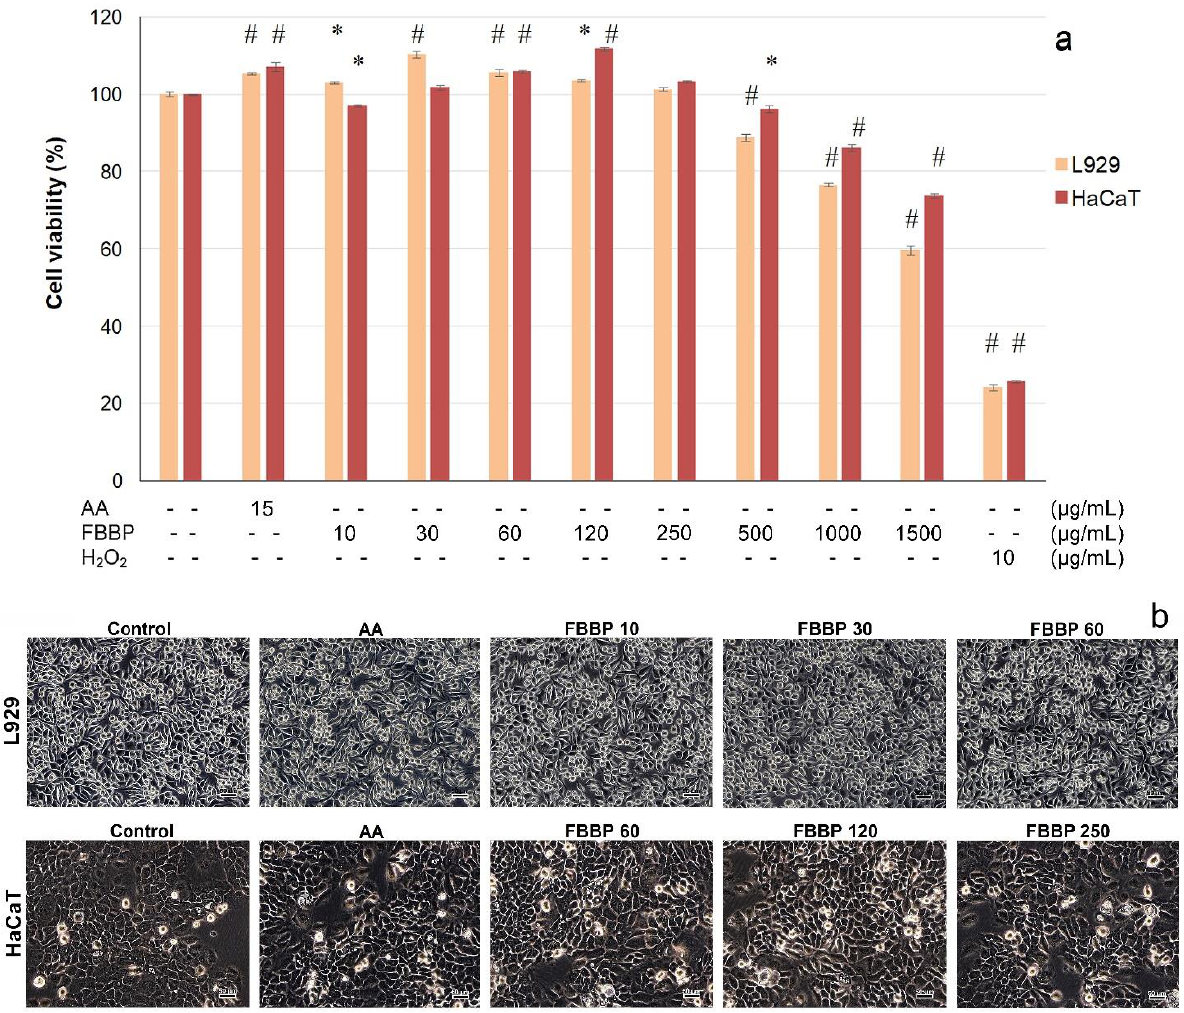
Figure 3. Cell viability of L929 and HaCaT cells cultivated in the presence of different concentrations of FBBP and AA at 48 h of cultivation, evaluated by MTT assay ( a ). The values are expressed as mean ± SD ( n = 3). * p < 0.05, # p < 0.01, compared to the untreated cells (control). Cells treated with H 2 O 2 served as positive control. Phase contrast microscopy observations of cell morphology in L929 and HaCaT cells cultivated in the presence of different concentrations of FBBP ( b ). Scale bar = 50 µm.